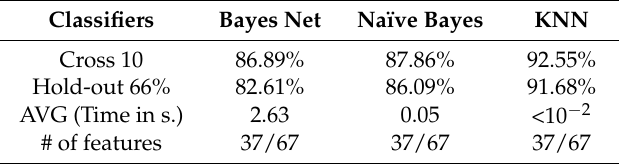
Table 9. Results using Info Gain Attribute Select of all feature features for Secure Password DB 150.